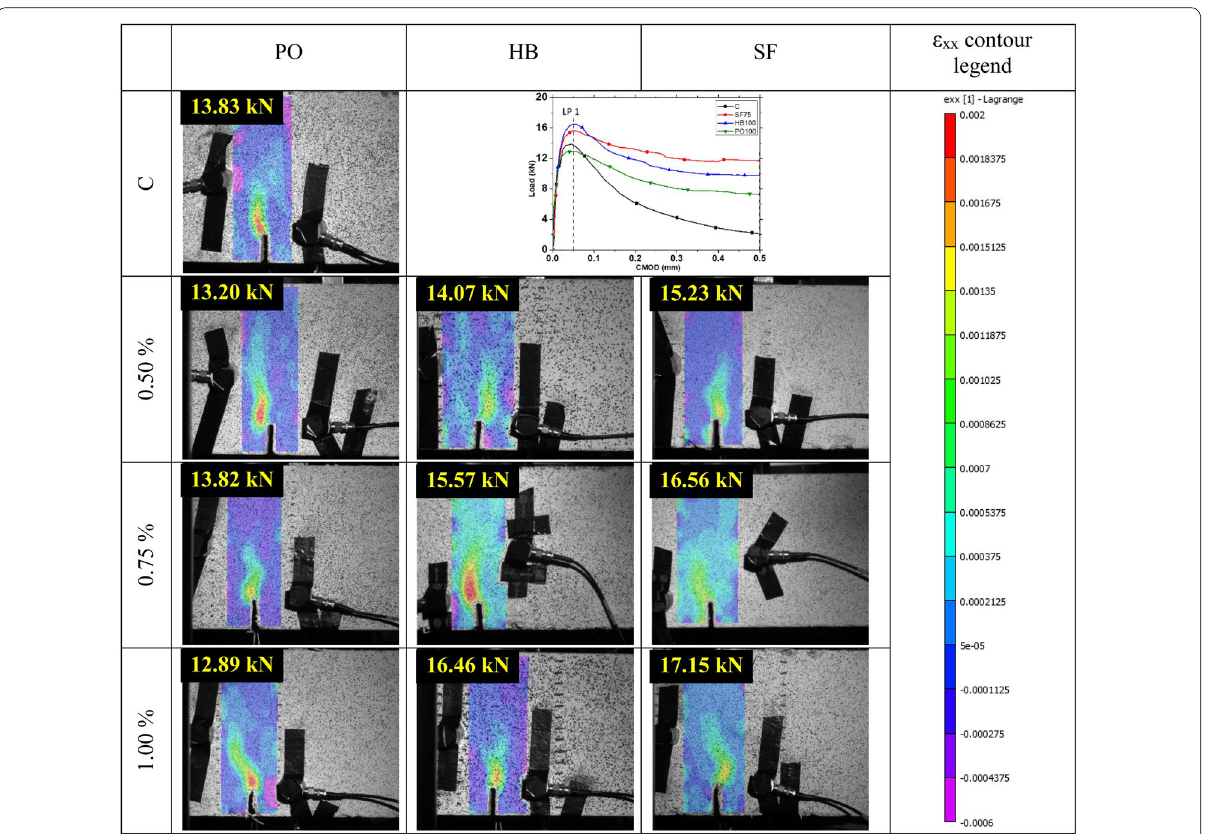
Fig. 12 Comparison of different FRCs with varying Vf value at cracking